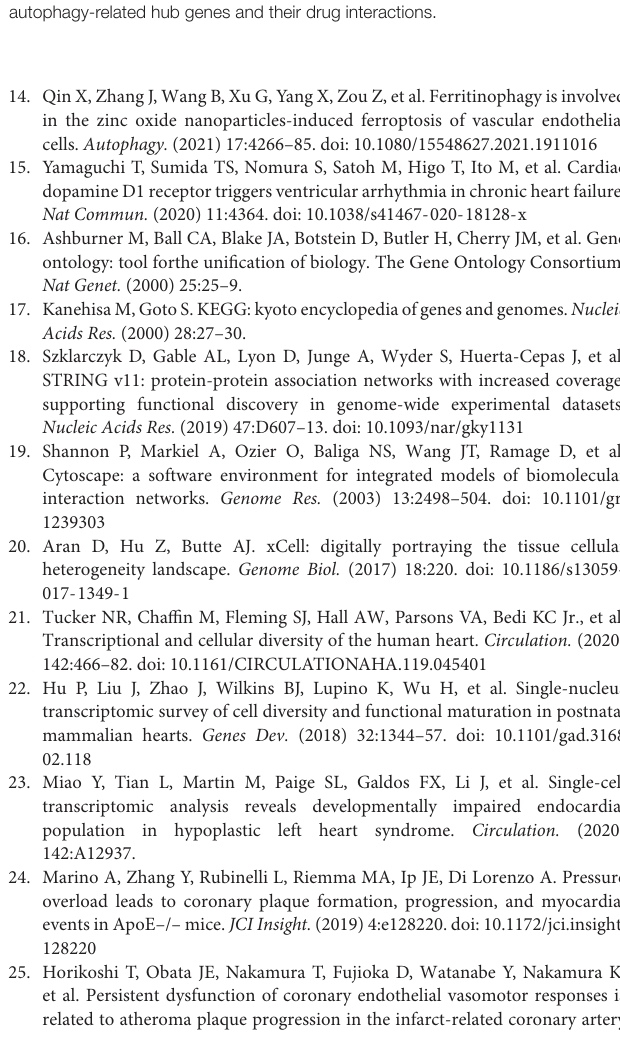
Supplementary Figure 1 | The PPI network of the DEGs in GSE116250. Supplementary Figure 2 | A Venn diagram of DEGs and ferroptosis genes. Supplementary Figure 3 | The network of the enriched pathways of ferroptosis-related genes. Supplementary Figure 4 | The network of the enriched pathways of autophagy-related genes. Supplementary Figure 5 | The PPI analysis of ferroptosis-related and autophagy-related DEGs together. (A) The PPI analysis of ferroptosis-related and autophagy-related DEGs together. Red, upregulated genes; blue, downregulated genes. (B) The top 20 of the DEGs mentioned above using MCC. (C) A Venn diagram of the DEGs mentioned above using MCC and MCODE analysis module. Supplementary Figure 6 | The ferroptosis-related hub genes and their interactions. (A) miRNA coregulatory interactions with the screened hub genes. (B) TF coregulatory interactions with the screened hub genes. Supplementary Figure 7 | The autophagy-related hub genes and their interactions. (A) miRNA interactions with the MCODE-1 hubgenes. (B) miRNA interactions with the MCODE-2 hubgenes. (C) TF interactions with the MCODE-1 hub genes. (D) TF interactions with the MCODE-2 hub genes. Supplementary Figure 8 | The hub genes and their druginteractions. (A) The ferroptosis-related hub genes and their druginteractions. (B) The autophagy-related hub genes and their drug